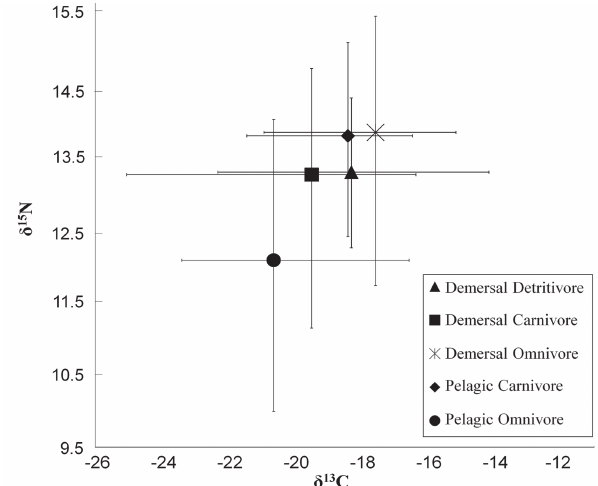
Fig. 2. δ 13 C and δ 15 N isotopic signatures of the trophic guilds of fish of the lower portion of the rio Paraíba do Sul watershed. Bars represent standard deviations.